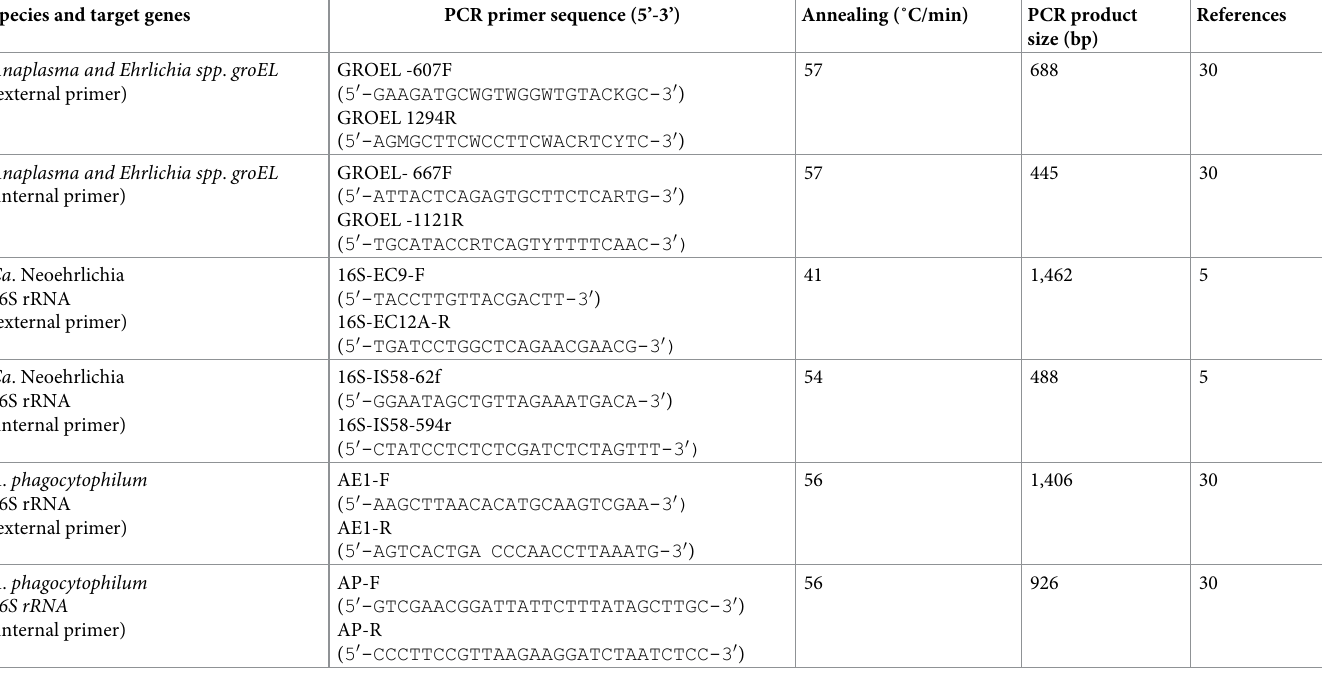
Table 1. Nucleotide sequences of polymerase chain reaction primers and conditions for amplification of Anaplasma and Candidatus Neoehrlichia species genes. Species and target